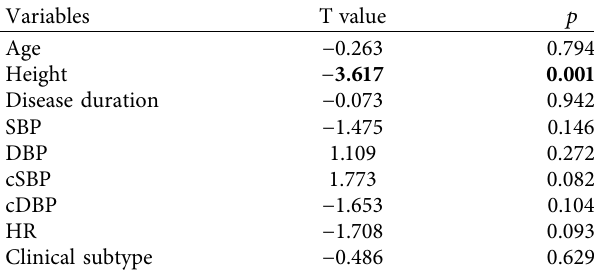
Table 4: Multivariate regression analysis of Ai in diffuse SSc vs. limited SSc vs.